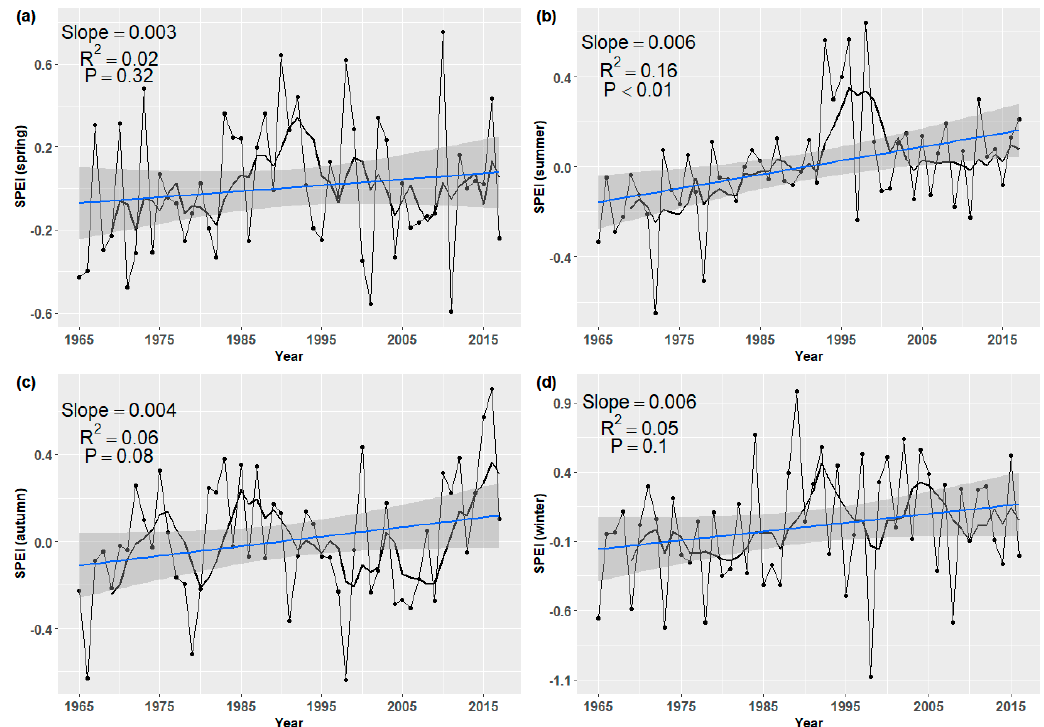
Figure 4. Linear trends of the seasonal standardized precipitation evapotranspiration index (SPEI) from 1965 to 2017: ( a ) spring, ( b ) summer, ( c ) autumn, and ( d ) winter SPEI. The bold black line shows the 5-year moving average value. The blue line shows the trend lines at a 95% confidence interval. p indicated that the significance levels ( p < 0.01 indicated the significant level of 0.01).